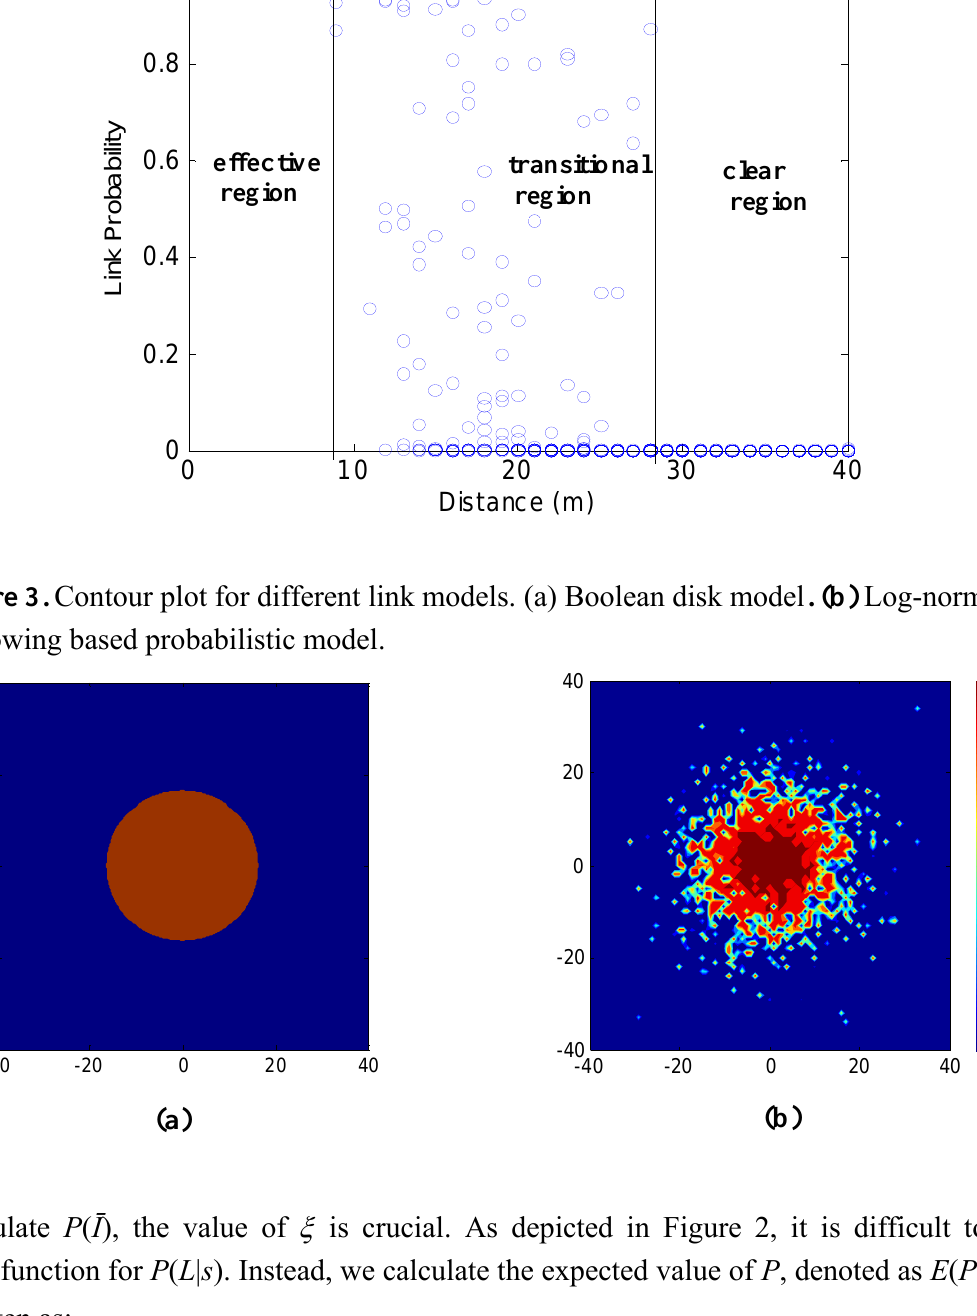
=-5 dB, η =3, σ =3.3, t